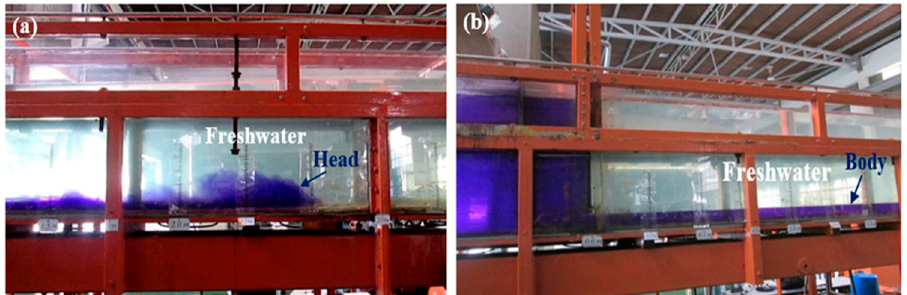
Figure 3. ( a ) Head and ( b ) body of a density current flowing under a layer of stationary ambient freshwater.